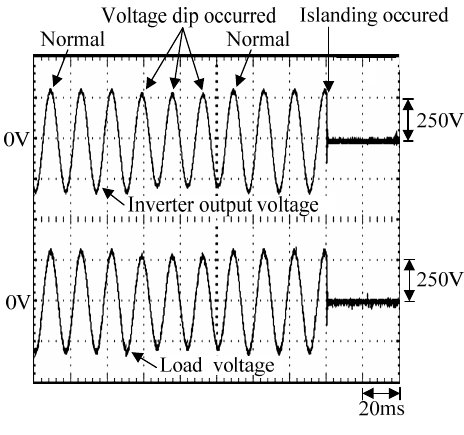
Figure 12. Diagram of islanding detection (harmonic components added to the system voltage before utility grid disconnection).